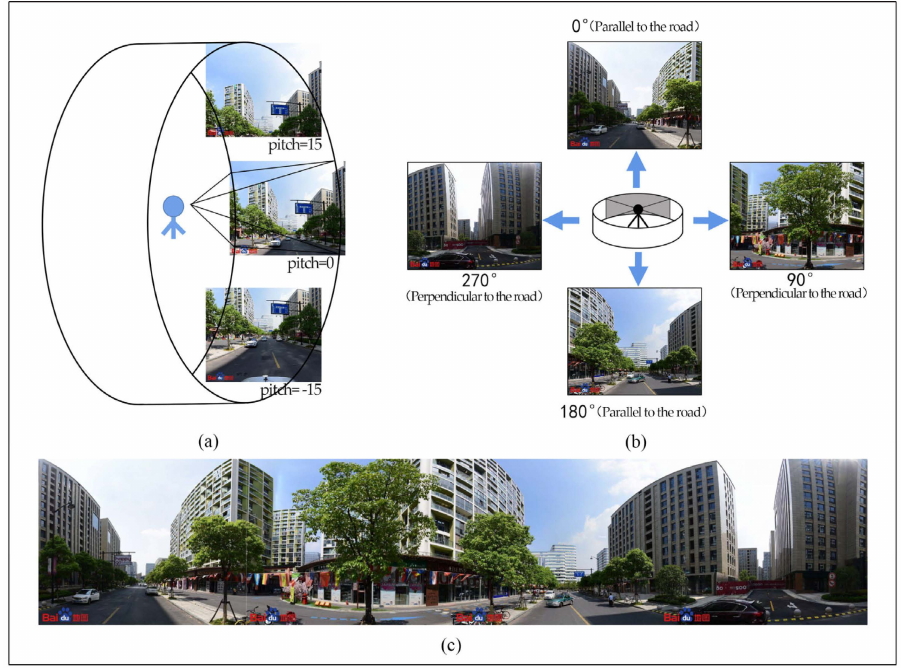
Figure 4. Schematic diagram of street view image acquisition: ( a ) Different vertical viewing angles; ( b ) Street view images in four directions; ( c ) Panorama of street view sampling